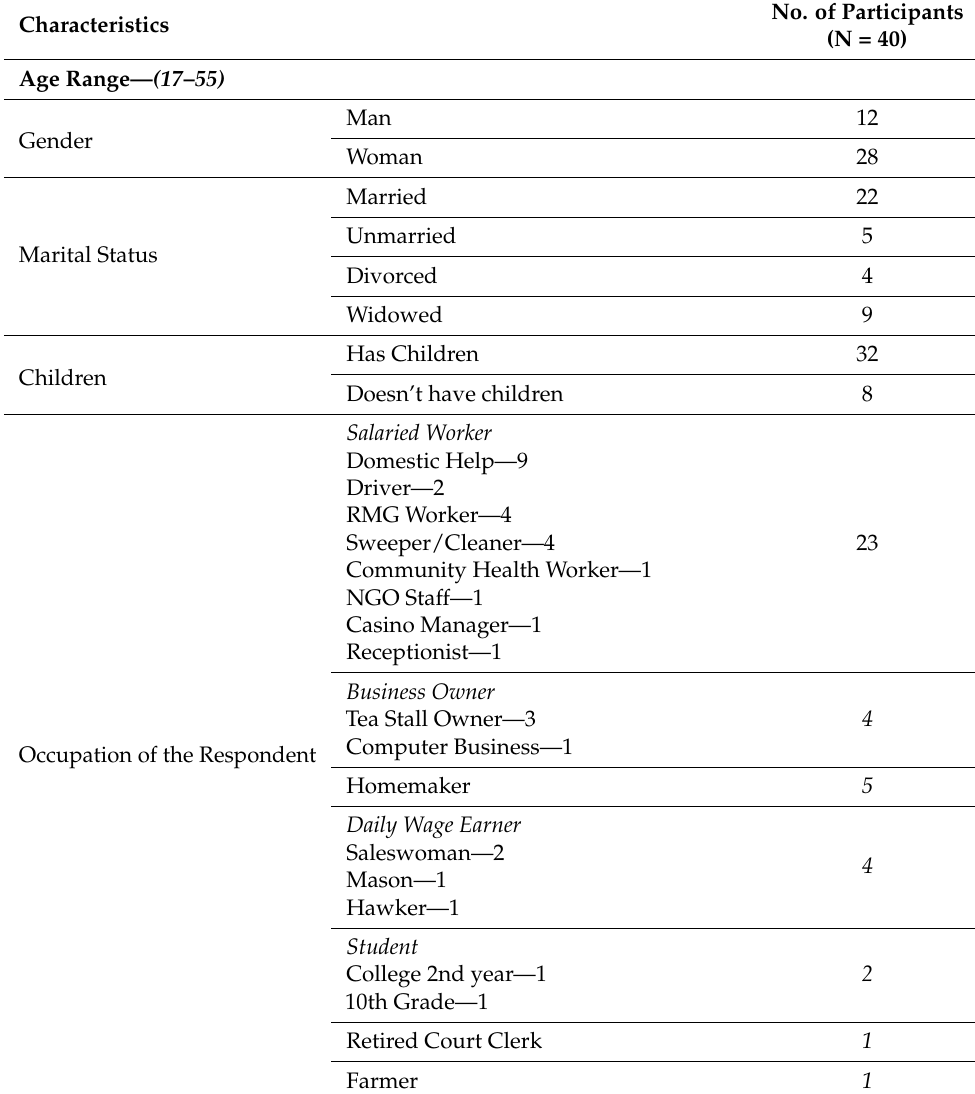
Table 1. The demographic information for our respondents is tabulated below.